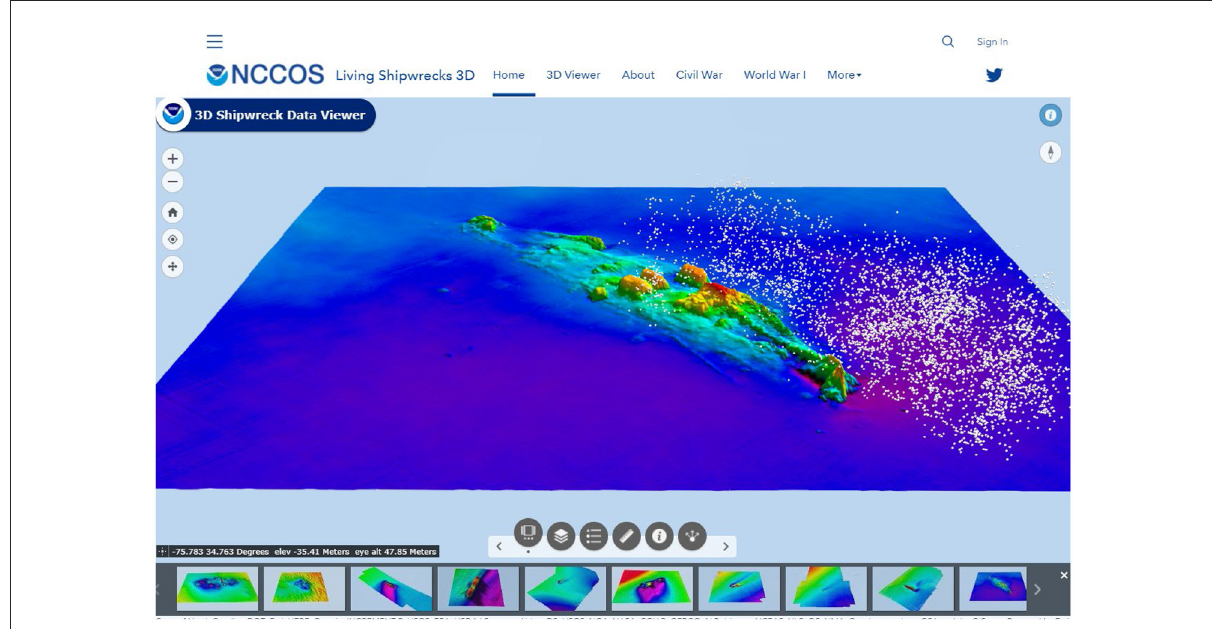
FIGURE2 “Living Shipwrecks 3D” is an online interactive tool that displays habitat mapping data collected from acoustic surveys over shipwrecks, as well as photographs and videos. The tool combines bathymetry maps with maps of fish (white circles) detected with